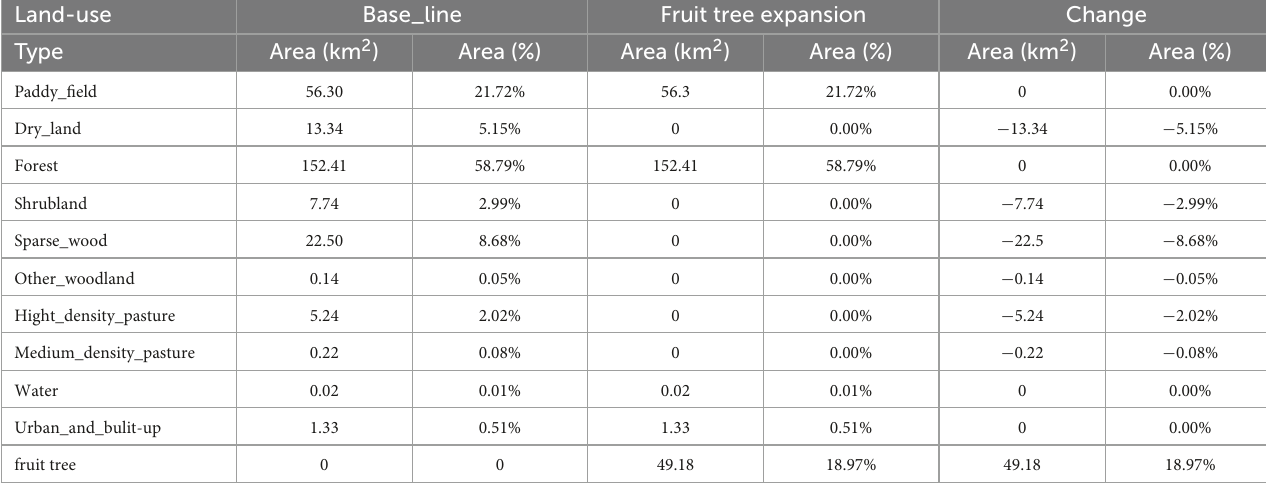
TABLE 2 Land use type conversion from the baseline period to fruit tree